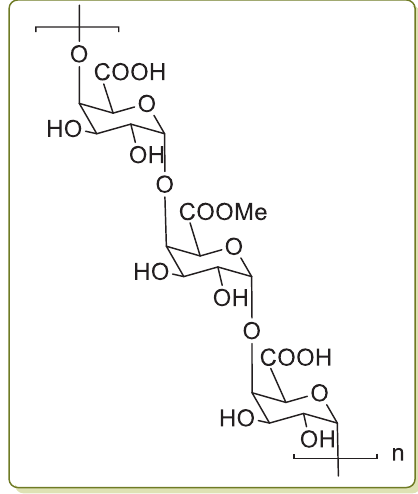
Figure 3. Chemical structure of